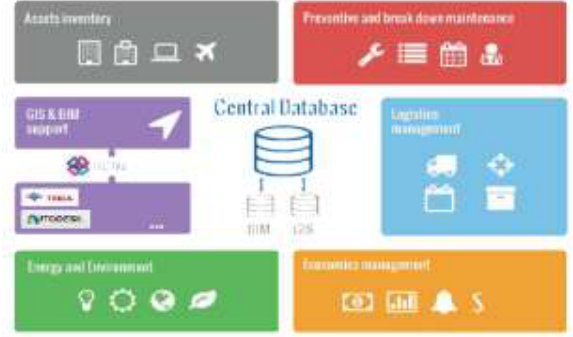
Figure 17. OpenMaint